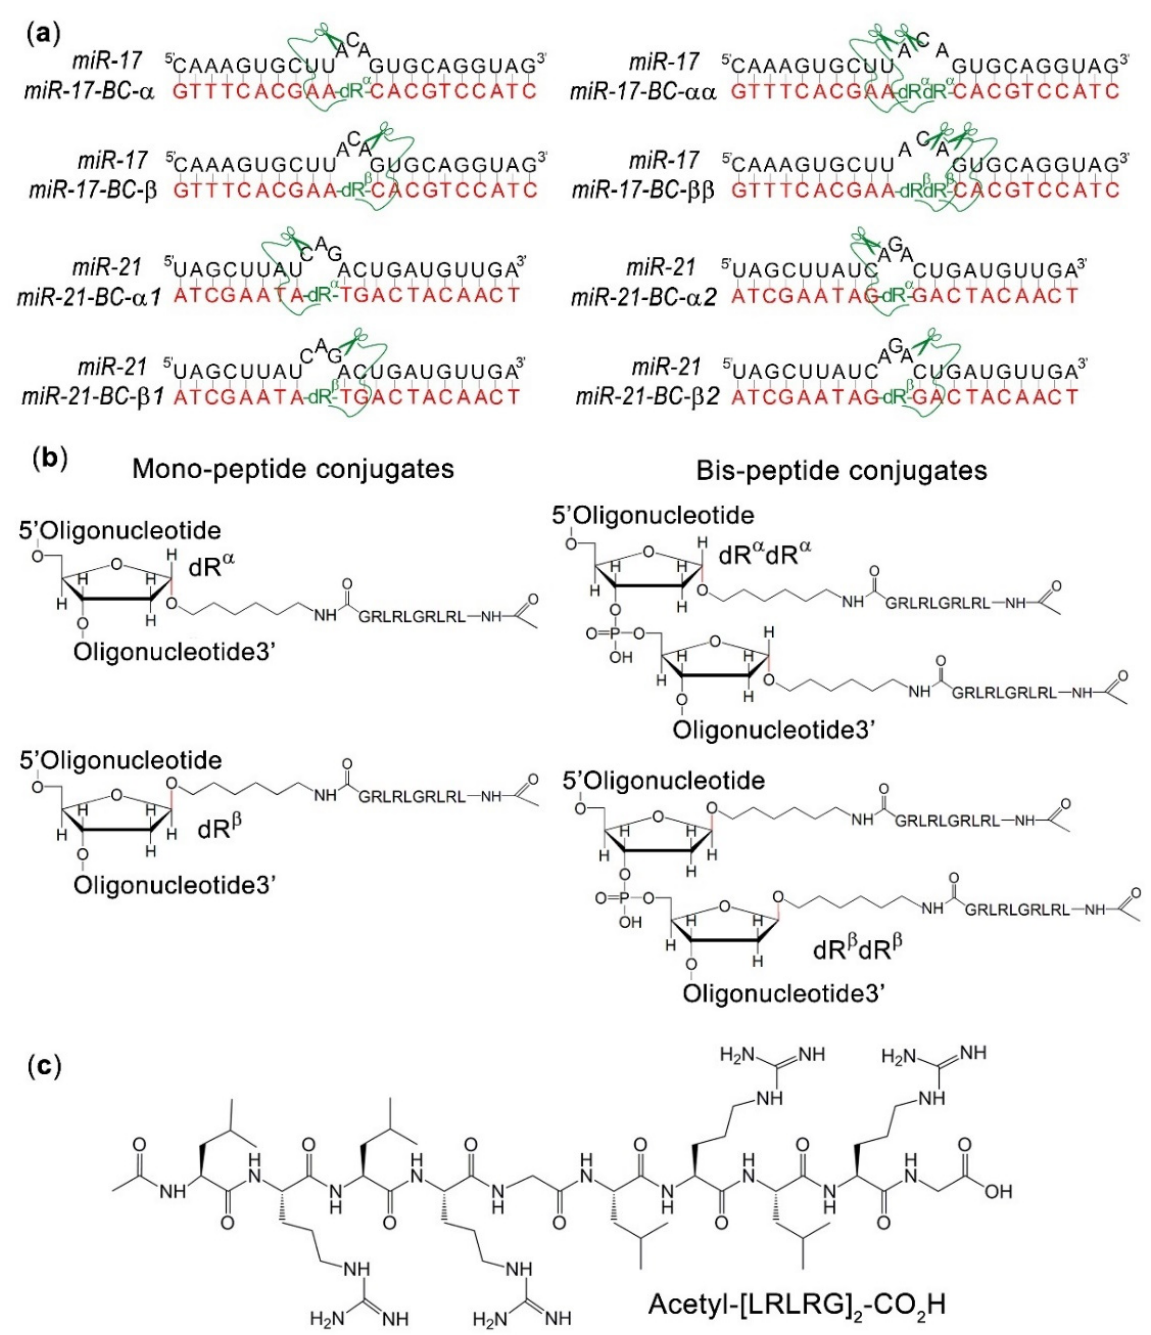
Figure 1. ( a ) Design concept for bulge-forming mono-conjugates (miR-17–BC- α , miR-17–BC- β , miR-21–BC- α 1, miR-21–BC- β 1, miR-21–BC- α 2, and miR-21–BC- β 2) and bis-conjugates (miR-17–BC- αα and miR-17–BC- ββ ) targeted to miR-17 and miR-21. ( b ) Structural organization of the peptide at ‐